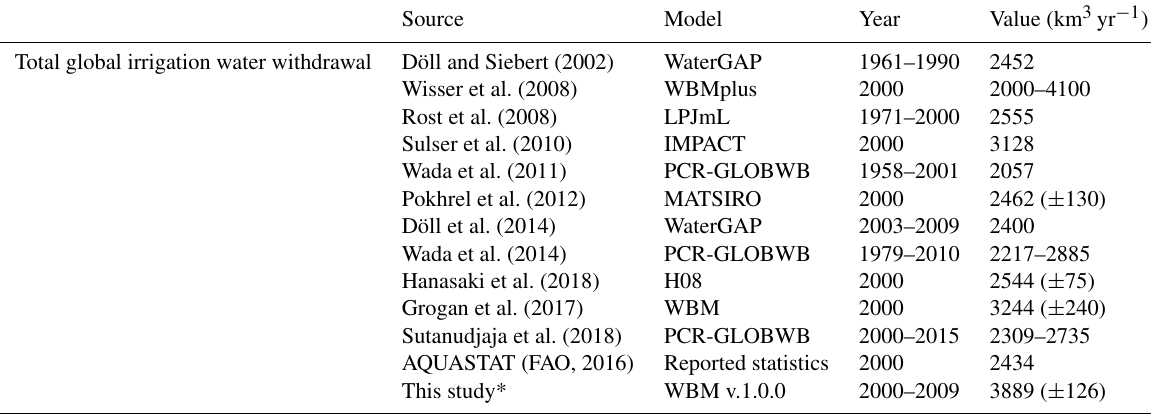
Table 6. Global estimates of total irrigation water withdrawal, including this study’s simulation.